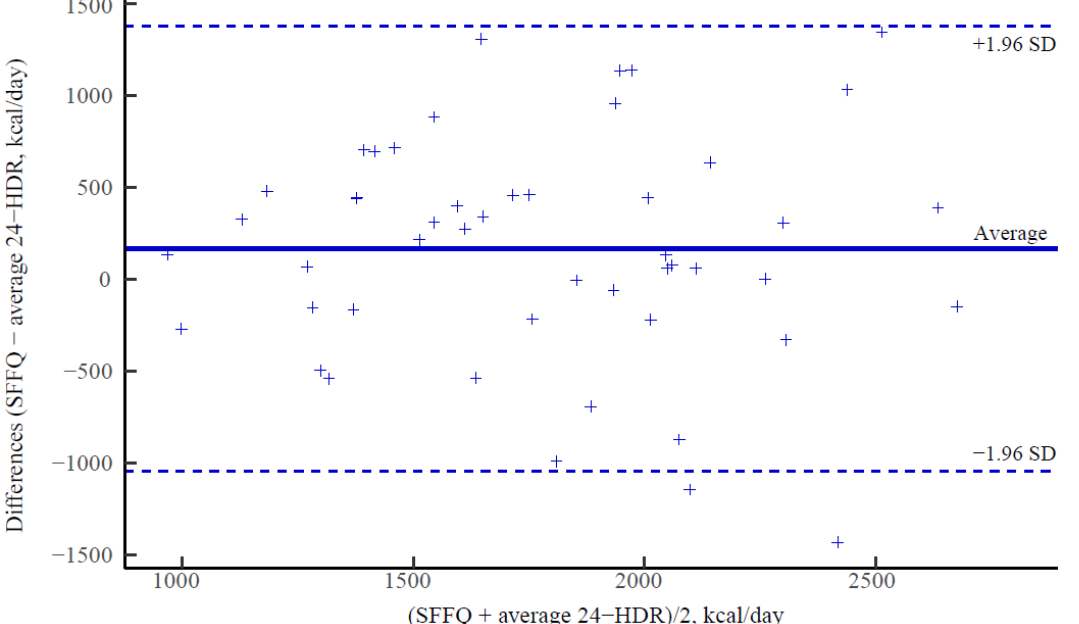
Figure 1. Bland – Altman plot of total daily energy intake reported by each participant. The Y axis is the difference between estimate of total energy intake measured by SFFQ and average three 24- HDRs. The X axis is the average energy intake of the two methods. The central solid horizontal line represents the average difference between the two methods for all participants, and the dashed lines represent the ±1.96 standard deviation (SD) of the average difference.